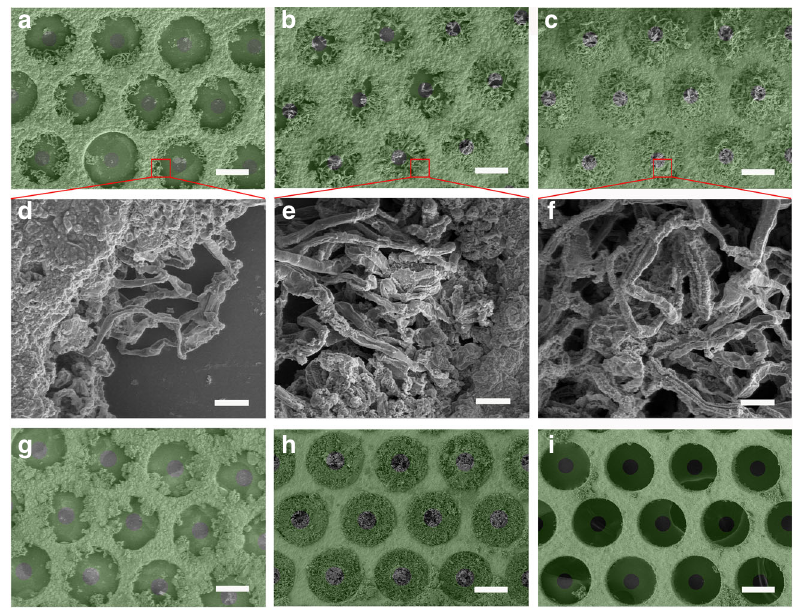
Fig. 4 Morphologies of Li metal anodes during plating/stripping. a – f SEM images of E-Cu after Li deposition at 0.5 mA cm − 2 with different capacities: a , d 0.5 mA h cm − 2 ; b , e 1 mA h cm − 2 ; and c , f 2 mA h cm – 2 . g – i SEM images of E-Cu after g stripping away 1 mA h cm − 2 of Li from E-Cu, followed by h plating back 1 mA h cm − 2 of Li into E-Cu and i re-stripping all Li metal from E-Cu. In these cases, 2 mA h cm − 2 of Li was primarily deposited into E-Cu at 0.5 mA cm − 2 . The green colour in the graphs of a – c and g – i represents the upper PI fi lm on the Cu scaffold. Scale bars in a – c and g – i are 100 μ m and in d – f are 10 μ m